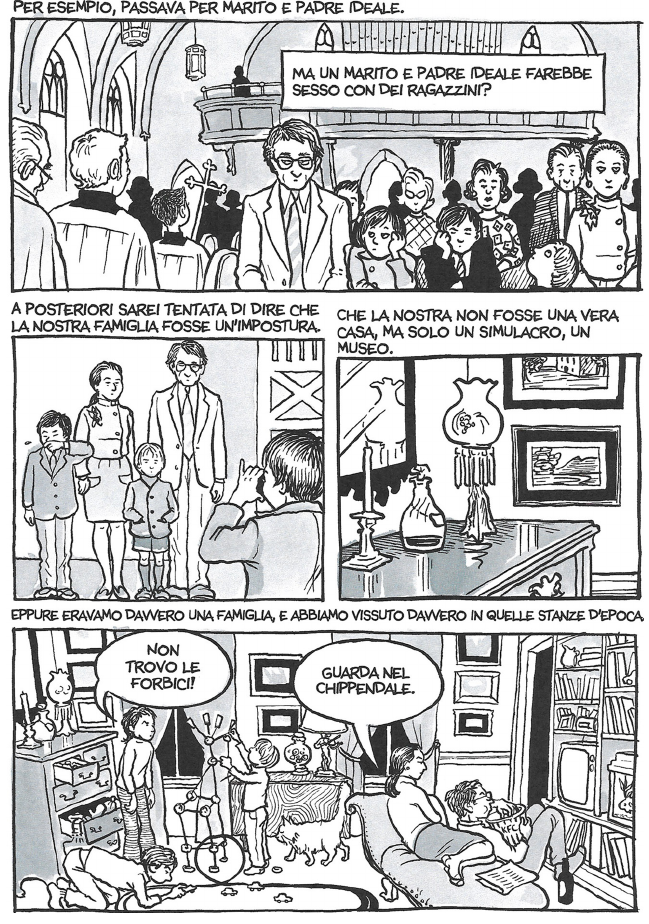
which Alison Bechdel expresses all the contradictions of her family and, in particular, of the father figure (Bechdel,